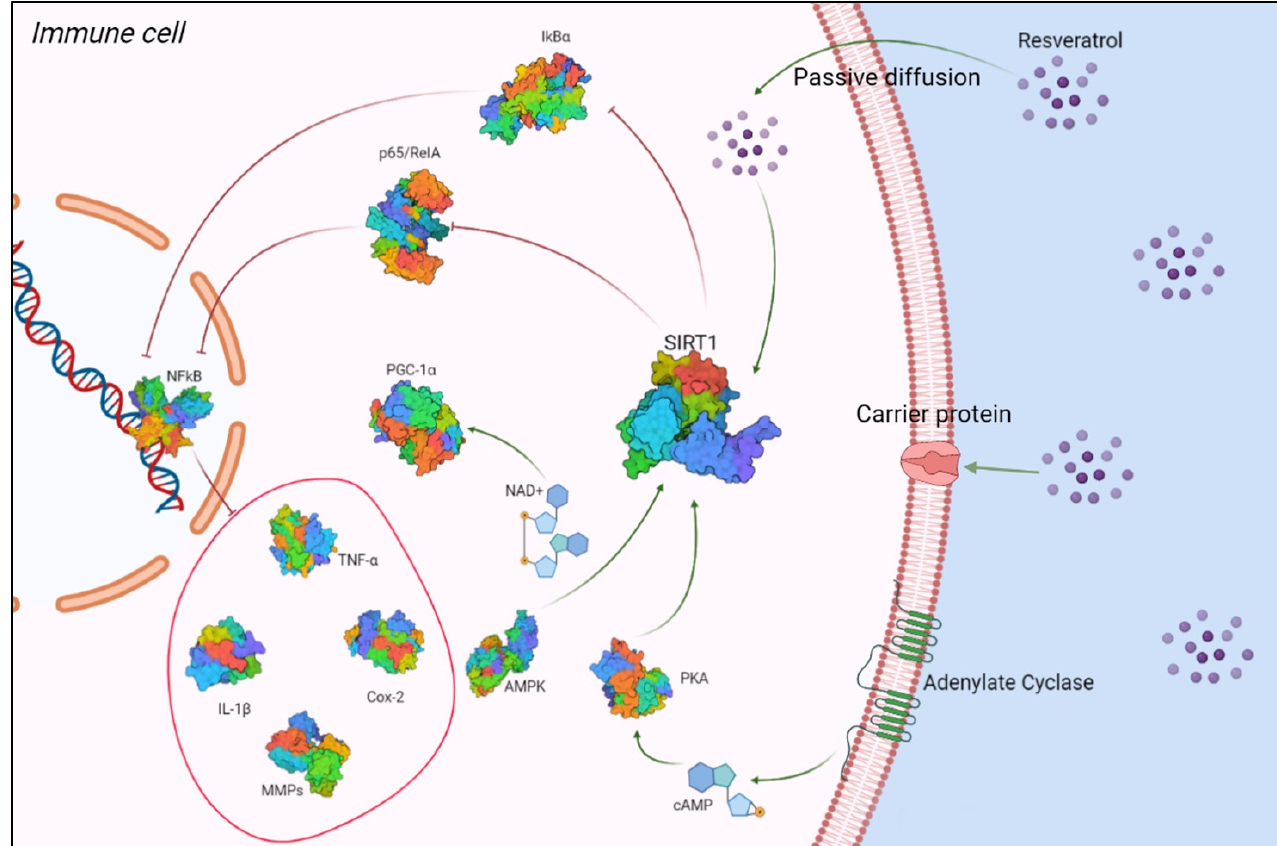
Figure 1. Interaction between RSV and SIRT1. Created with BioRender.com (Web online version 2021. Accessed on 28 December 2021).